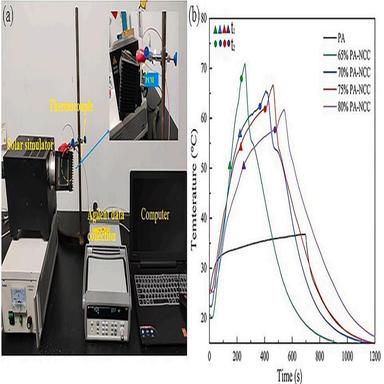
(a) The schematic diagram of the photo-thermal conversion test rig; (b) Light-to-heat conversion curves of NCC and PA-NCC.